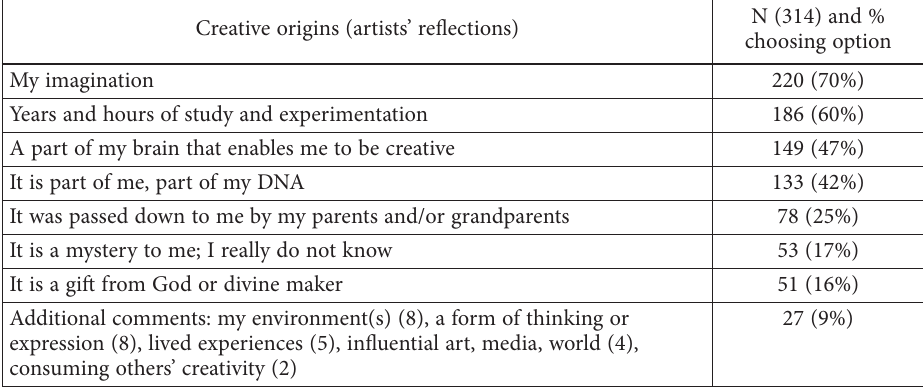
Table 3. Origins of participants’ creativity (source: created by author)